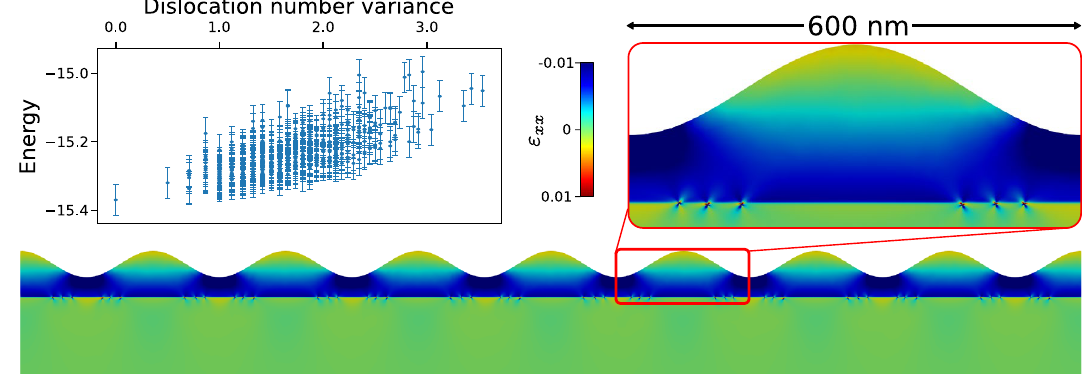
Figure 5. Minimum energy configuration obtained on a cell 4800 nm long using cutoff. Colormap shows xx component of the strain field. Left inset shows the energy of found local minima as a function of the variance of the number of dislocations below each valley in the free surface. Error bars give indicative errors in energy (approximately 3‰ of energy values). Right inset shows zooms in the vicinity of a single period of oscillation in the free surface. Dislocation separation by Burgers vector can be clearly